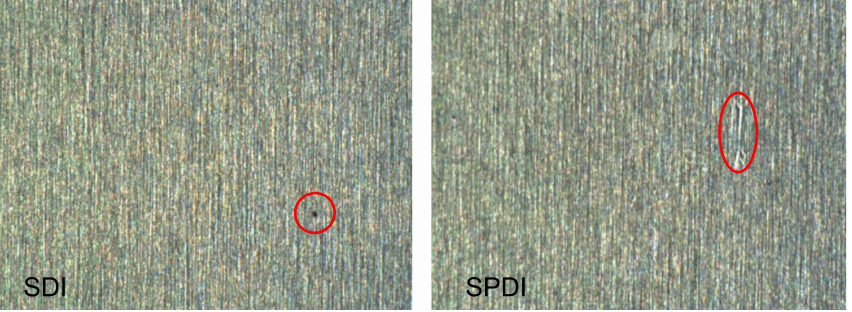
Figure 12. The image samples of two classes in the micro-surface defect database. Defects are marked with red